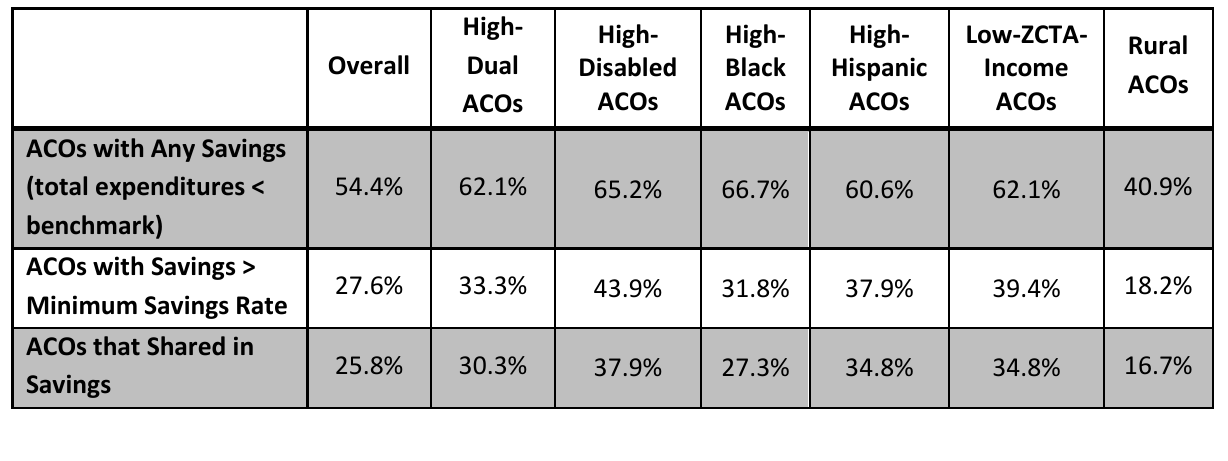
Table 9.10: ACO Expenditures and Savings by ACO Social Risk Composition,